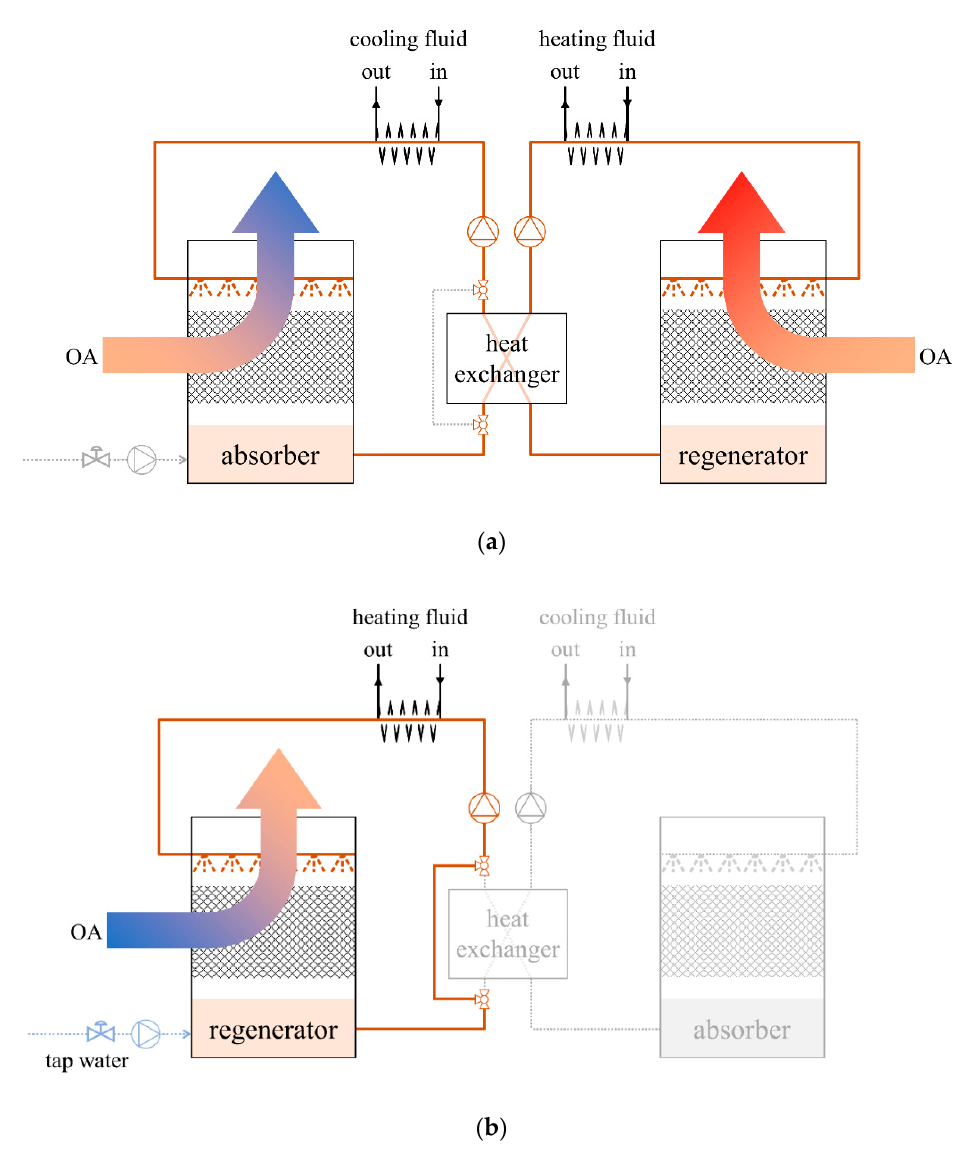
Figure 4. LD system design diagrams for ( a ) cooling and ( b ) heating seasons.